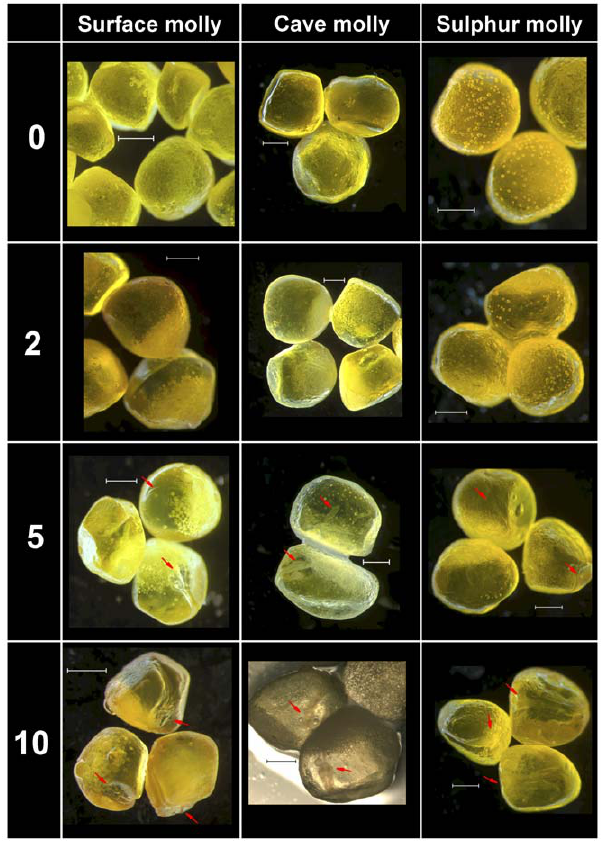
Figure 1. Comparative embryo development of two ecotypes of P. mexicana and of P. sulphuraria . Stages range from the unfertilised, but ripe oocyte (Stage 0), to the optic cup embryo (Stage 10). See Table 1 for details. Scale bar = 1 mm. Embryos of stage 2 are lateral view. Arrows at stage 5 indicate location of the primitive streak embryo; arrows at stage 10 indicate location of head and optic cups.